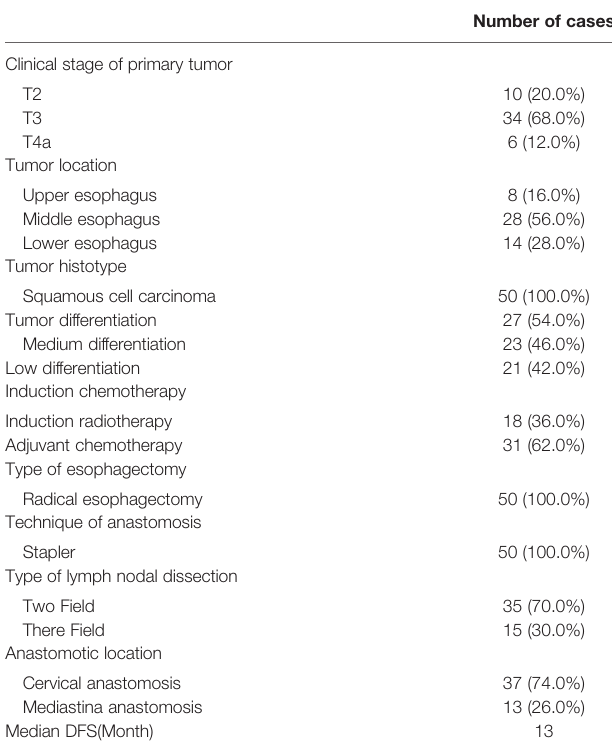
TABLE 2 | Patient characteristics of before and after